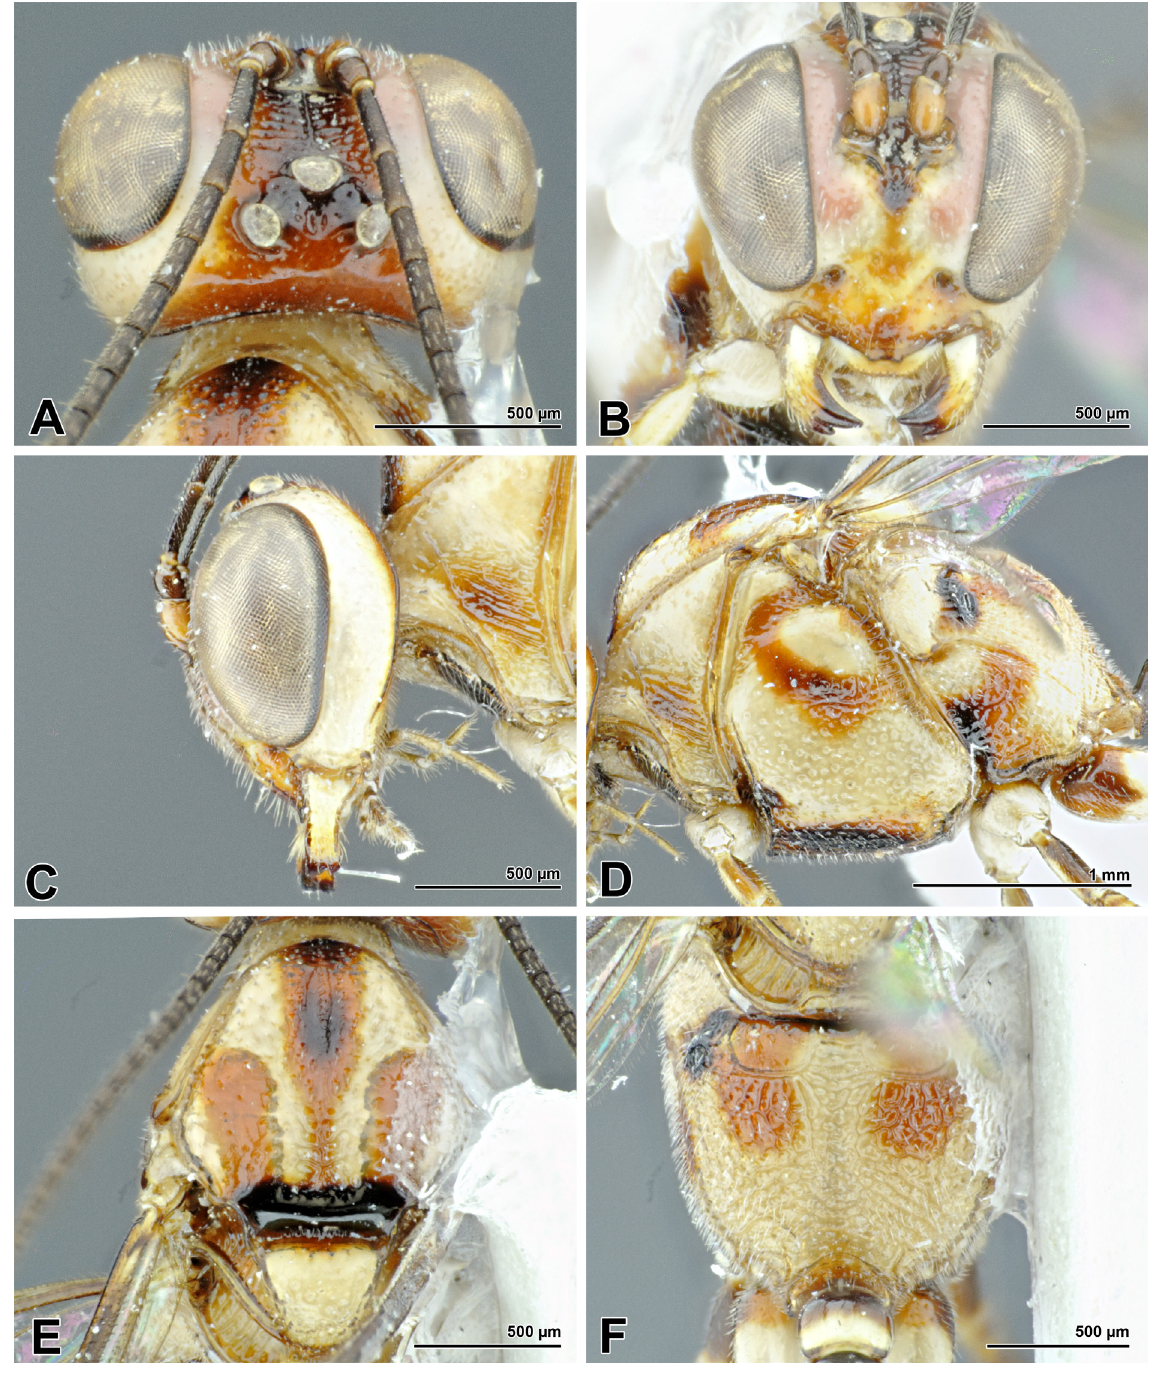
Fig. 4. Anomalon chinense (Kokujev, 1915), ♀, DPPZ. A . Head, dorsal view. B . Head, frontal view. C . Head, lateral view. D . Mesosoma, lateral view. E . Mesoscutum, dorsal view. F . Propodeum, dorsal